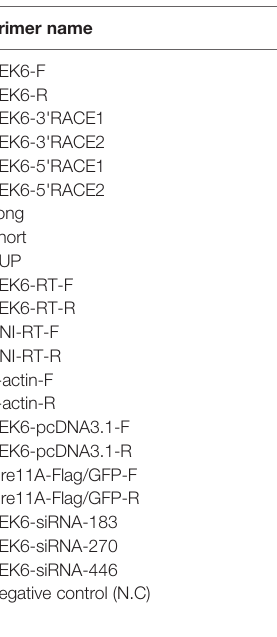
TABLE 1 | Sequences and applications of the primers used in this